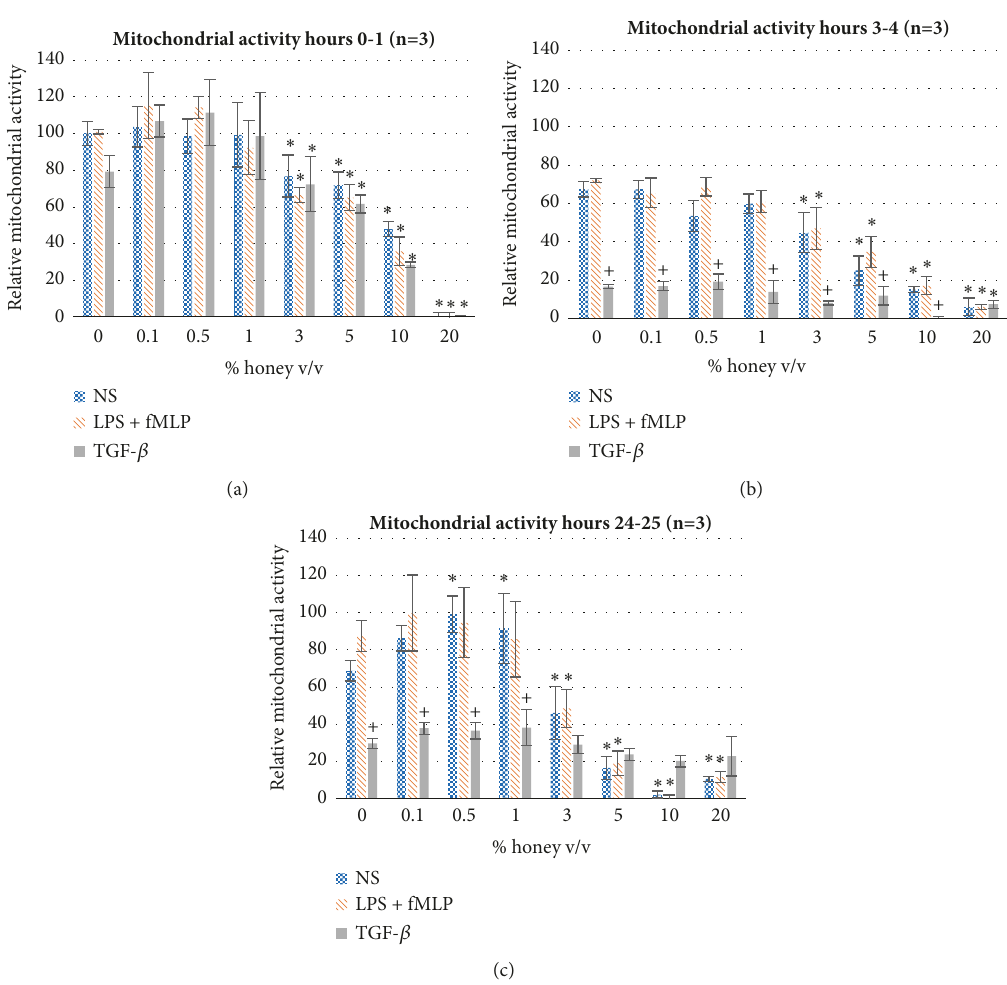
Figure 1: Mitochondrial activity of NS, LPS/fMLP, and TGF- 𝛽 -stimulated dHL-60s at various concentrations of honey for hours (a) 0-1, (b) 3-4, and (c) 24-25 of culture. Values are normalized relative to the 0-1-hour NS 0% honey mitochondrial activity. ∗ indicates statistical significance from the respective 0% honey value of that phenotype/timepoint, and + indicates statistical significance from the other two phenotypes at that honey concentration and timepoint. 𝛼 =0.05, measured via two-way ANOVA with Holm-Sidak post hoc.